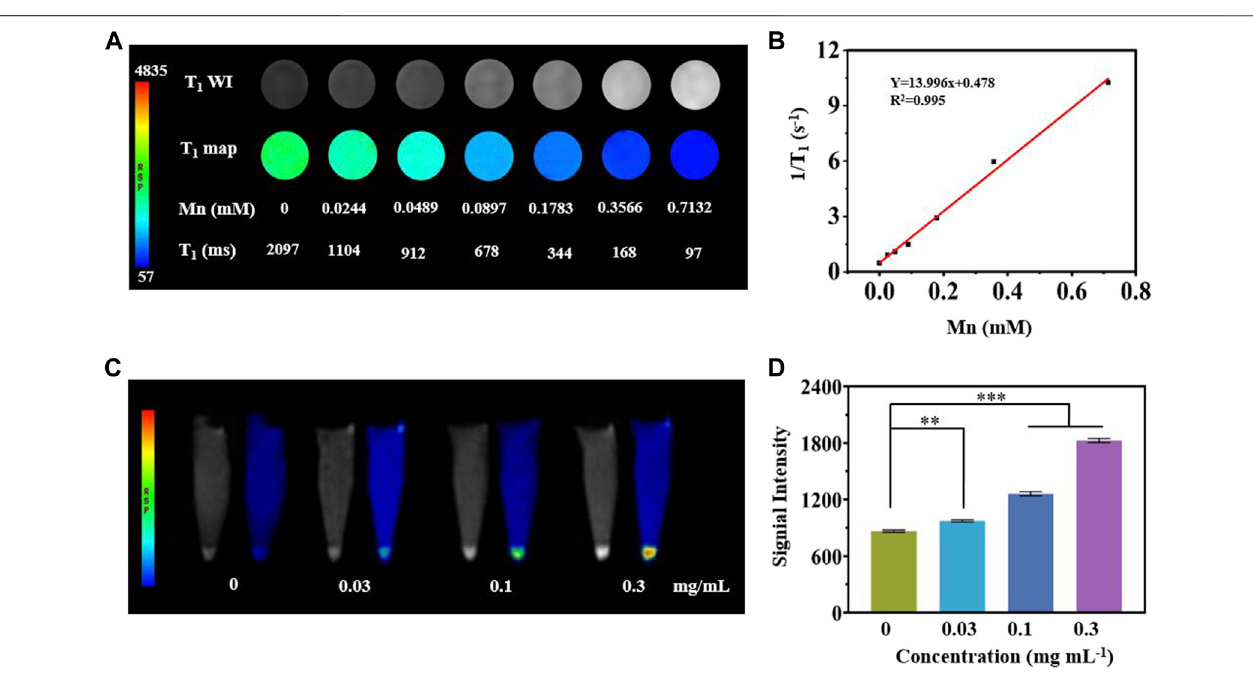
Frontiers in Bioengineering and Biotechnology |